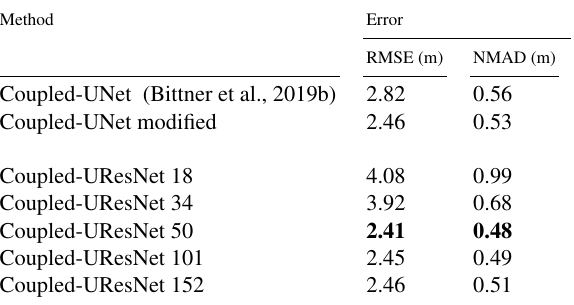
Table 1. Quantitative results for RMSE and NMAD metrics evaluated over selected test area of Berlin